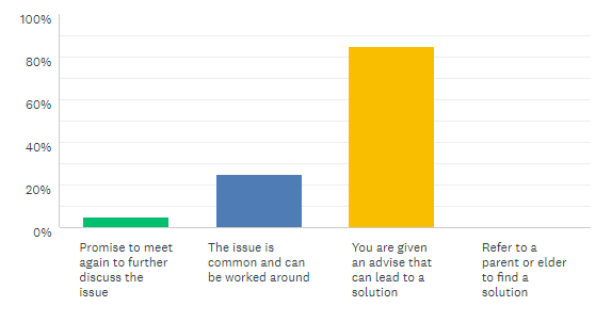
Figure 6. Respondent’s views on positive outcomes